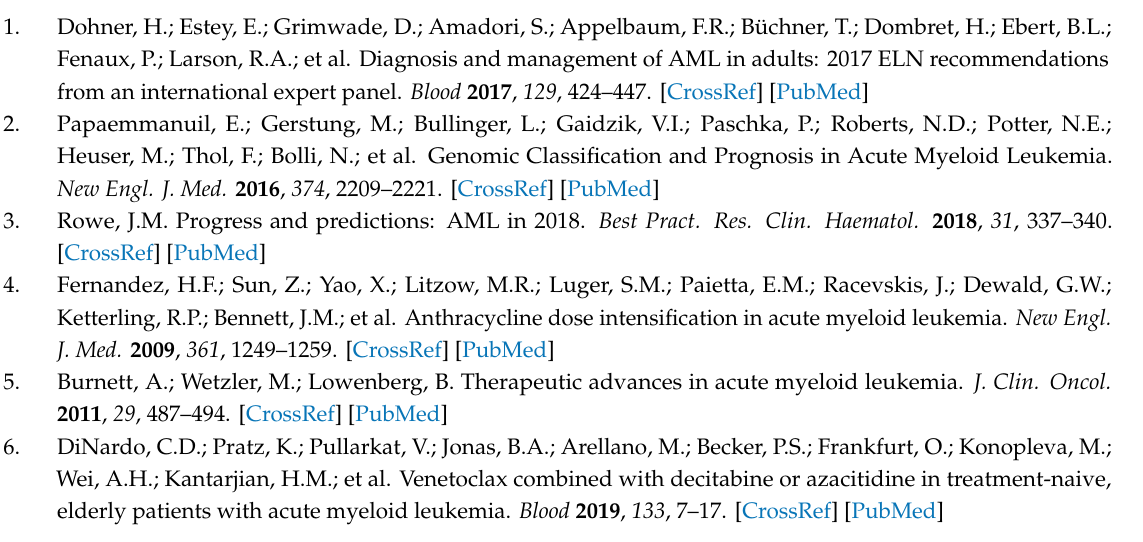
Supplementary Figure S1 Correspondence between protein levels (A) via Western blot and mRNA levels (B) via QRT-PCR. Protein quantification (C) by ImageJ software. The images in (A) are taken from two di ff erent blots; the samples were derived from the same experiment and the blots were processed in parallel. Supplementary Figure S2 Evolution of BCL2 levels in 18 individual patients with follow up BCL2 values available at diagnosis (Dx), complete remission (CR) and relapse (RL). Supplementary Table S1 Comparison of BCL2 expression levels at di ff erent points during follow up. Supplementary Table S2 Dichotomized value of BCL2 expression level with the area under the ROC curve for overall survival (OS). Supplementary Table S3 Dichotomized value of BCL2 expression level with the area under the ROC curve for progression-free survival (PFS). Supplementary Table S4 Univariate and multivariate progression-free survival analysis in the whole series at diagnosis (Dx). Supplementary Table S5 Univariate survival